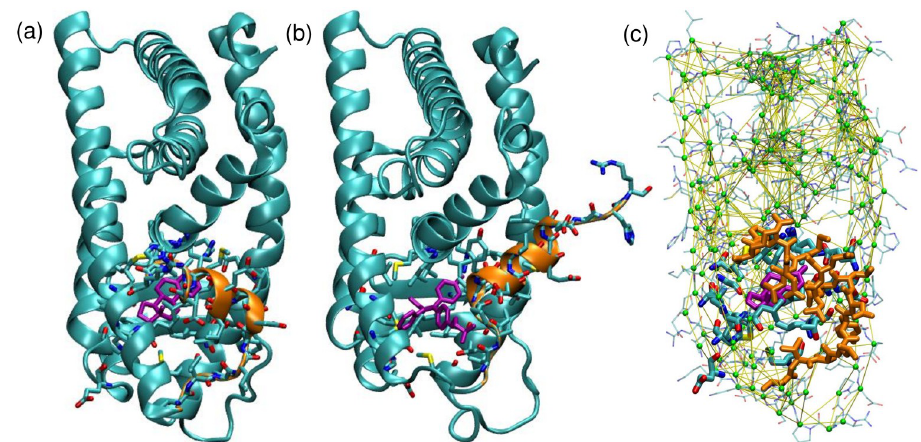
Fig 1. Structure of ER α . (a) Active and (b) inactive conformation of ER α . (c) Illustration of the mixed-resolution model used in this paper. The ligand (purple) and the binding site (heavy structure) constitute the atomistic region and are treated using an all-atom force field. The remainder of the protein is treated as the coarse-grained region is represented by particles located at each α carbon (green spheres) with native attractions between them (yellow lines). Rigid structures of each amino acid (thin structure) and moved along with the coarse-grained particles and used to calculate interactions between the coarse-grained and atomistic regions. Helix 12 is indicated in orange in all three